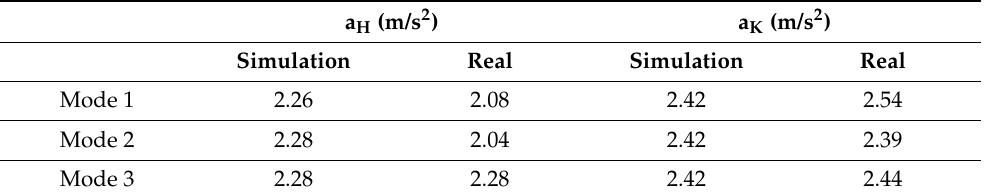
Figure 10. Acquired results from IMU sensor in terms of linear accelerations of H: ( a ) for Mode 1; ( b ) for Mode 3. ( b ) for Mode 3. Table 6. Comparison of the results from the dynamic simulation and real